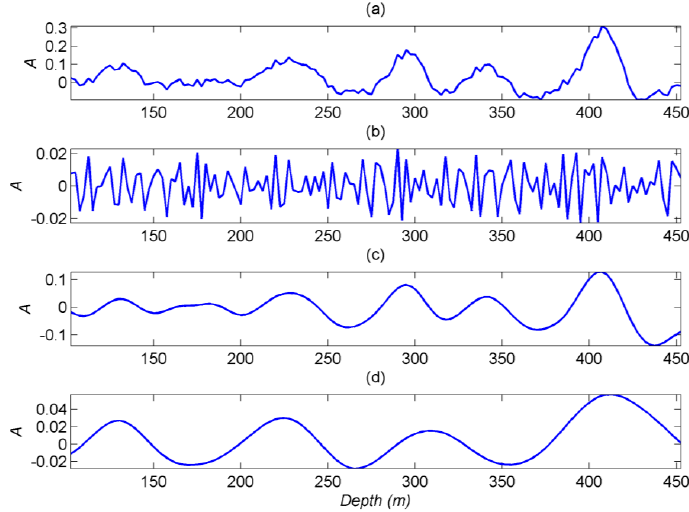
Figure 6. Analysis results of the synthetic seismic record using CEEMD: ( a ) the synthetic seismic record with 15% noise; ( b ) IMF1 of the record; ( c ) IMF2 of the record; and ( d ) IMF3 of the record.